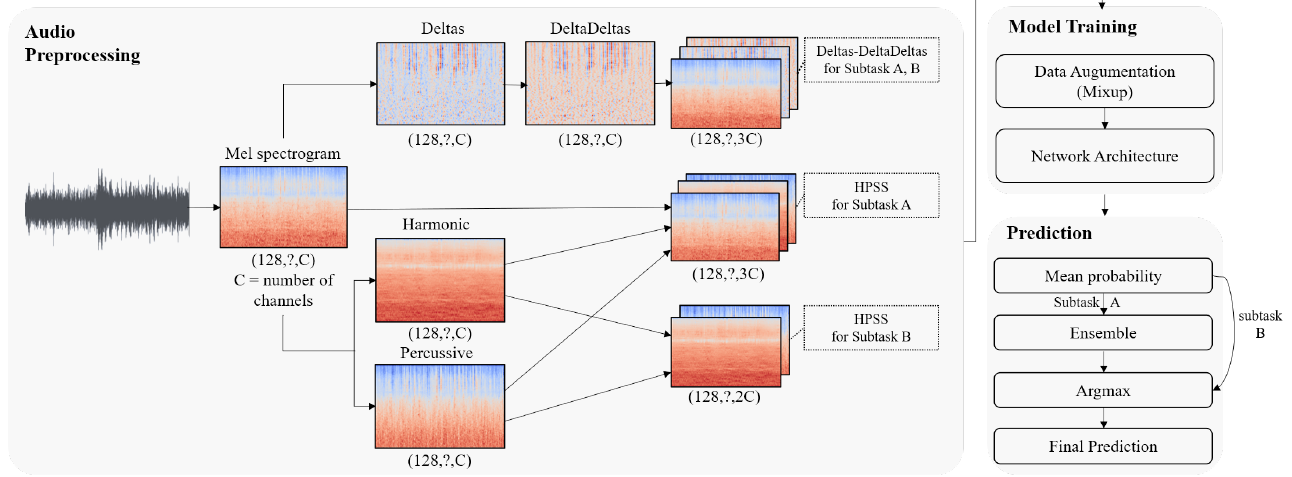
Figure 2. Proposed system